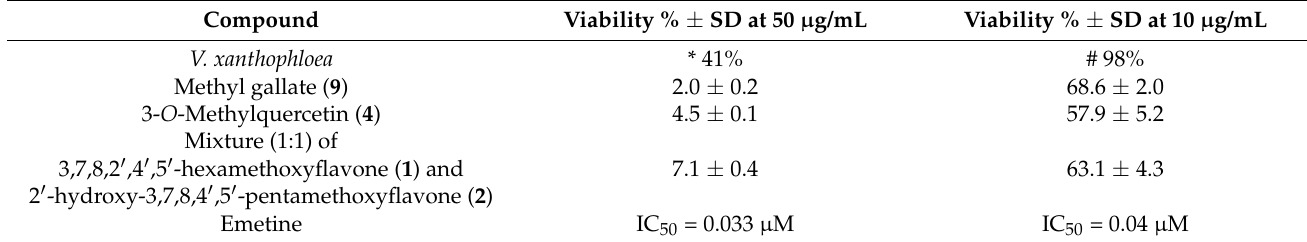
Table 3. In vitro cytotoxic activity of the extract and a few isolated compounds against HeLa